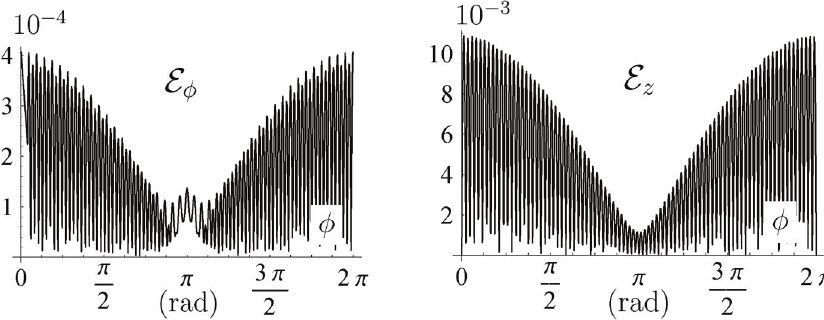
(cid:1) 0 : 97 at 1 GHz; L (cid:1) 42 but the coefficients are calculated at the order L 0 (cid:1) 60 . ( b (cid:1) 2 cm , n (cid:1) 1 =Y FIG. 12. E and E for Y (cid:19) z n 0